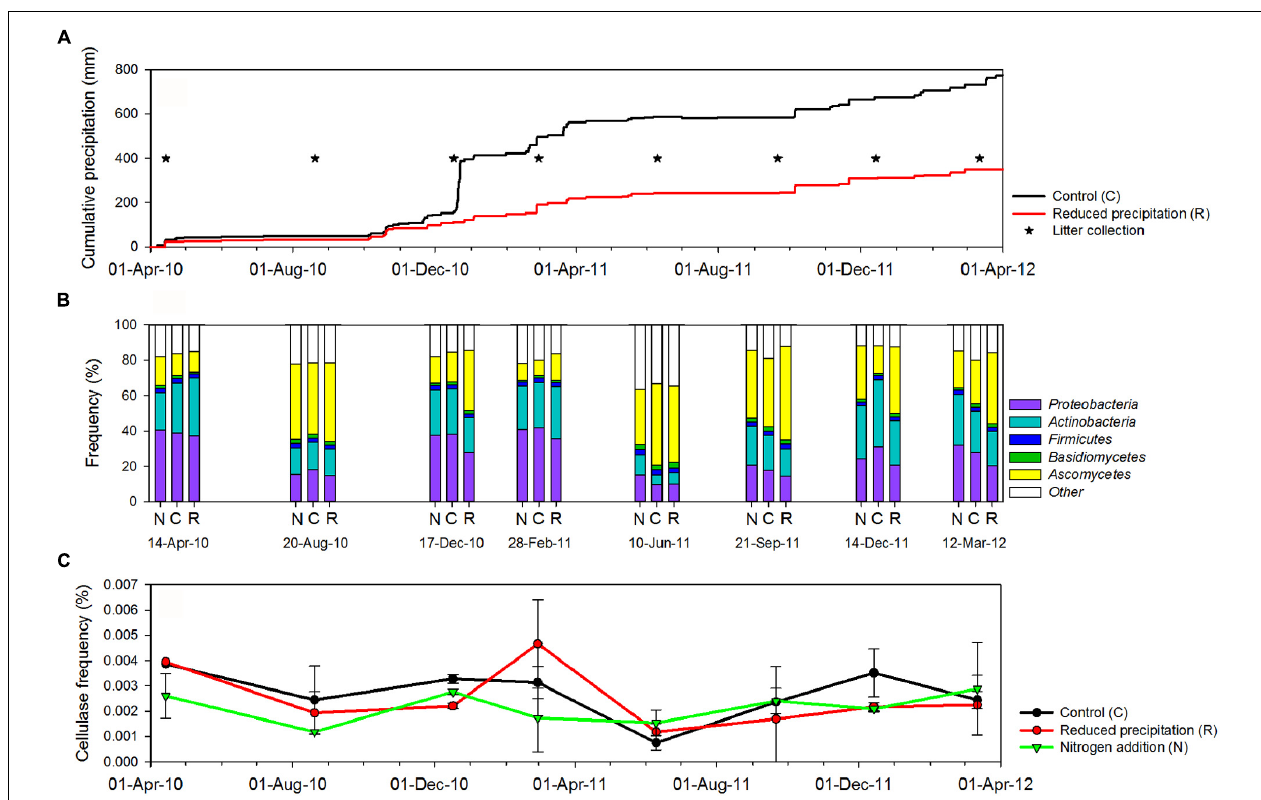
FIGURE 1 | (A) Cumulative precipitation at Loma Ridge study site. (B) Overall distribution of sequences with annotation in the major microbial phyla detected in the leaf litter metagenomes across treatments [control